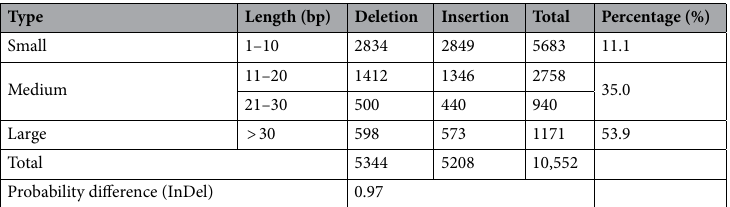
Table 3. Ranking of genome-wide InDels based on the length of nucleotide sequence.